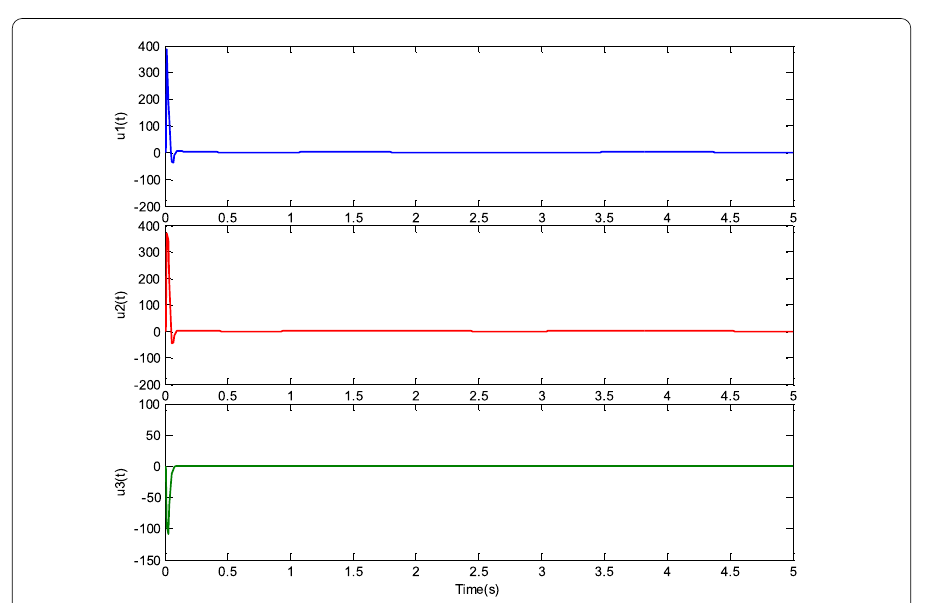
Figure 6 Time history of the FISMC controller